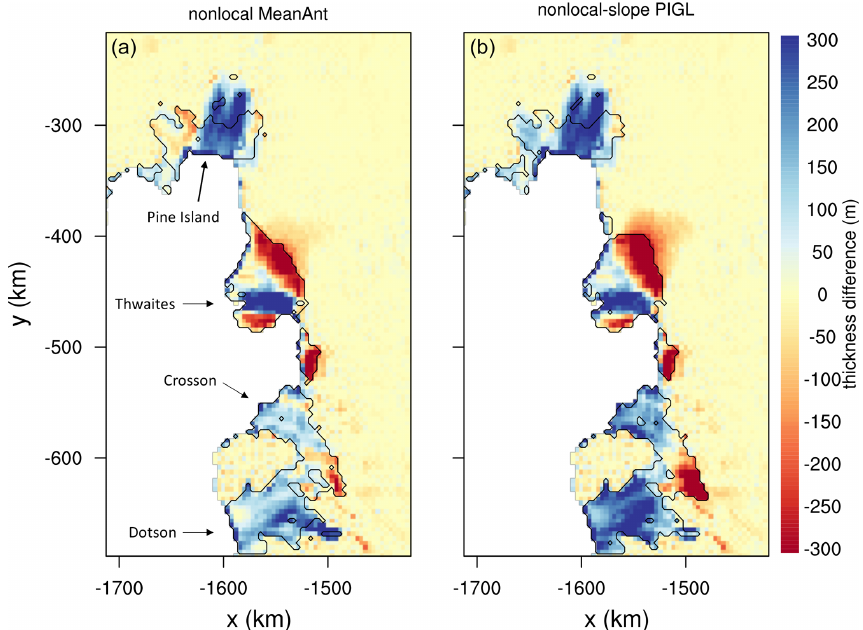
Figure 3. Same as Fig. 2, but focused on the Amundsen